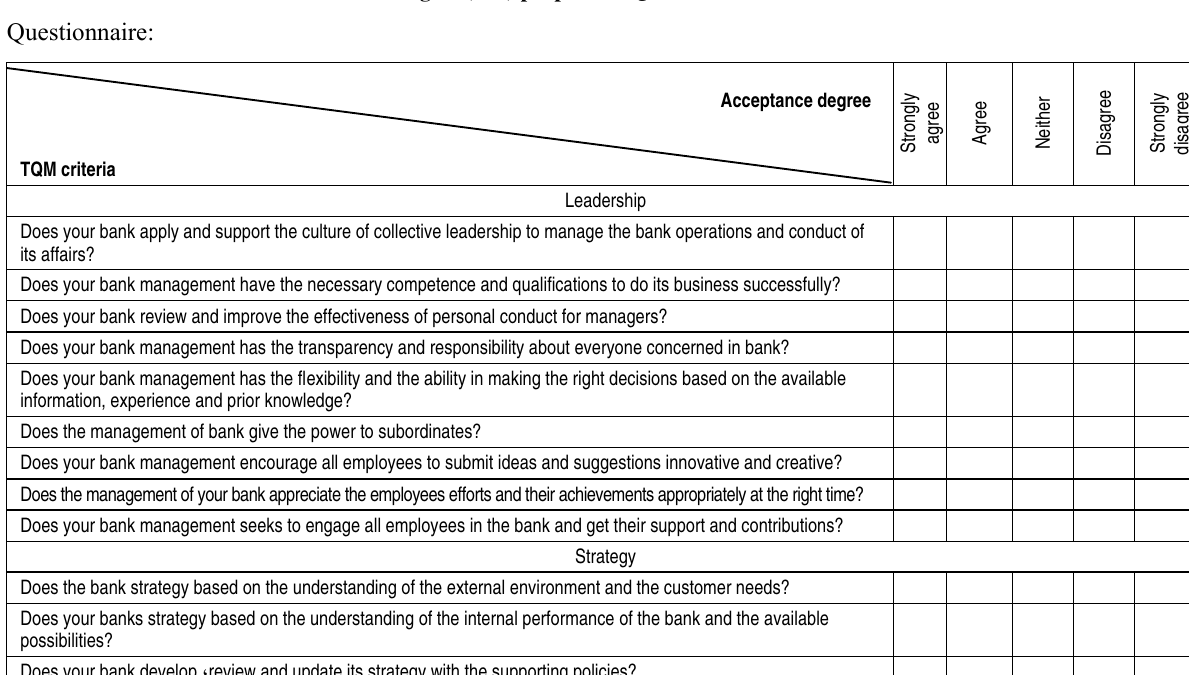
Fig. 1. (Jad) proposed TQM model in